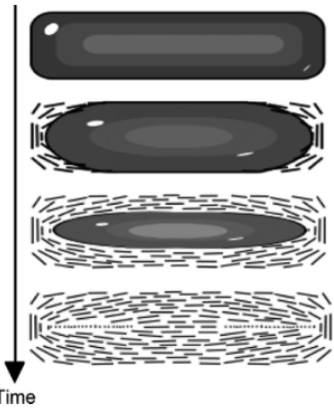
Figure 19. Process of evaporation behavior of an inkjet printed line resulting in oriented CNTs. Reproduced with permission [126]. Copyright 2012, American Chemical Society.